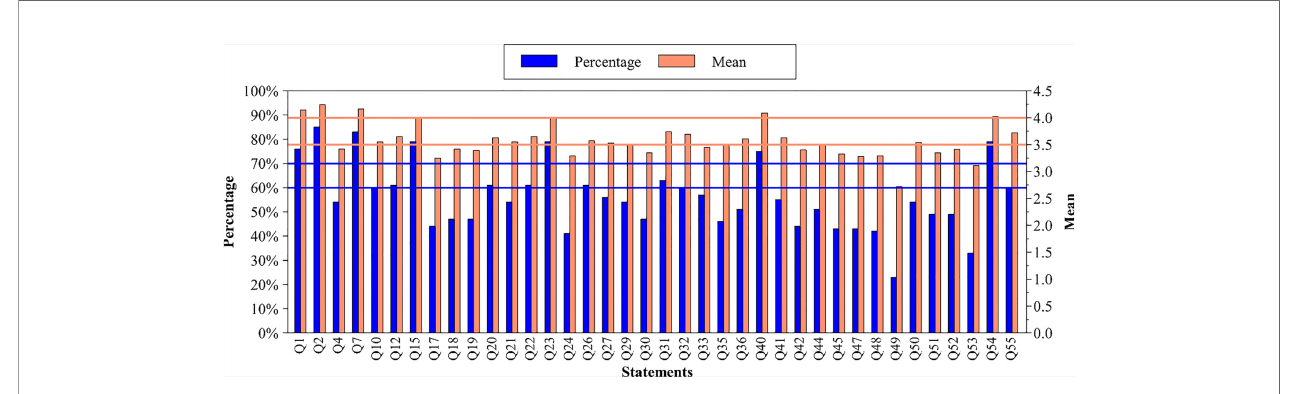
FIGURE 11 | Percentage of responses of Very/Extremely important and mean values of the statements that reach consensus at the fi rst